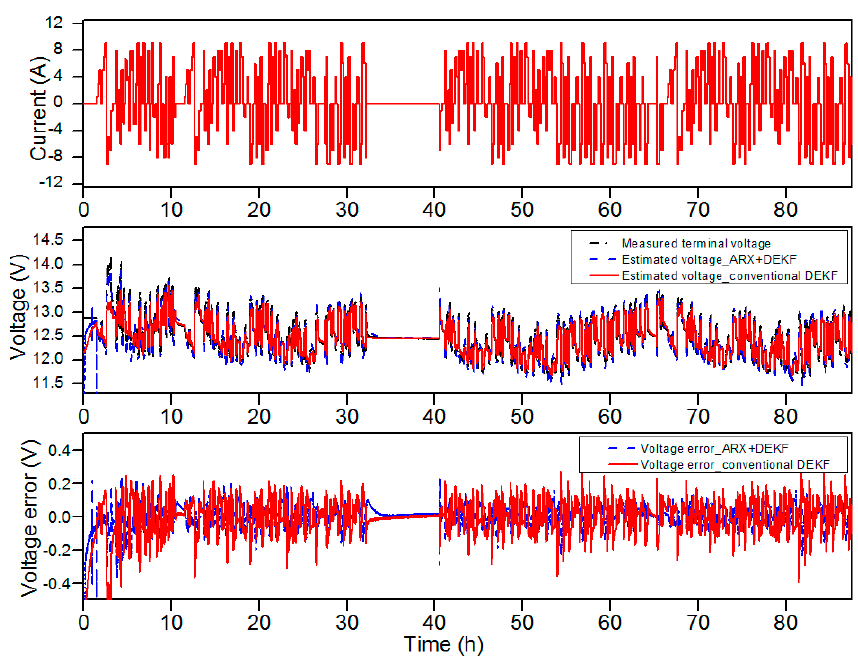
Figure 7. Comparison of the terminal voltage estimation for the aged battery (75.6% SOH) by the proposed ARX DEKF and conventional DEKF method.